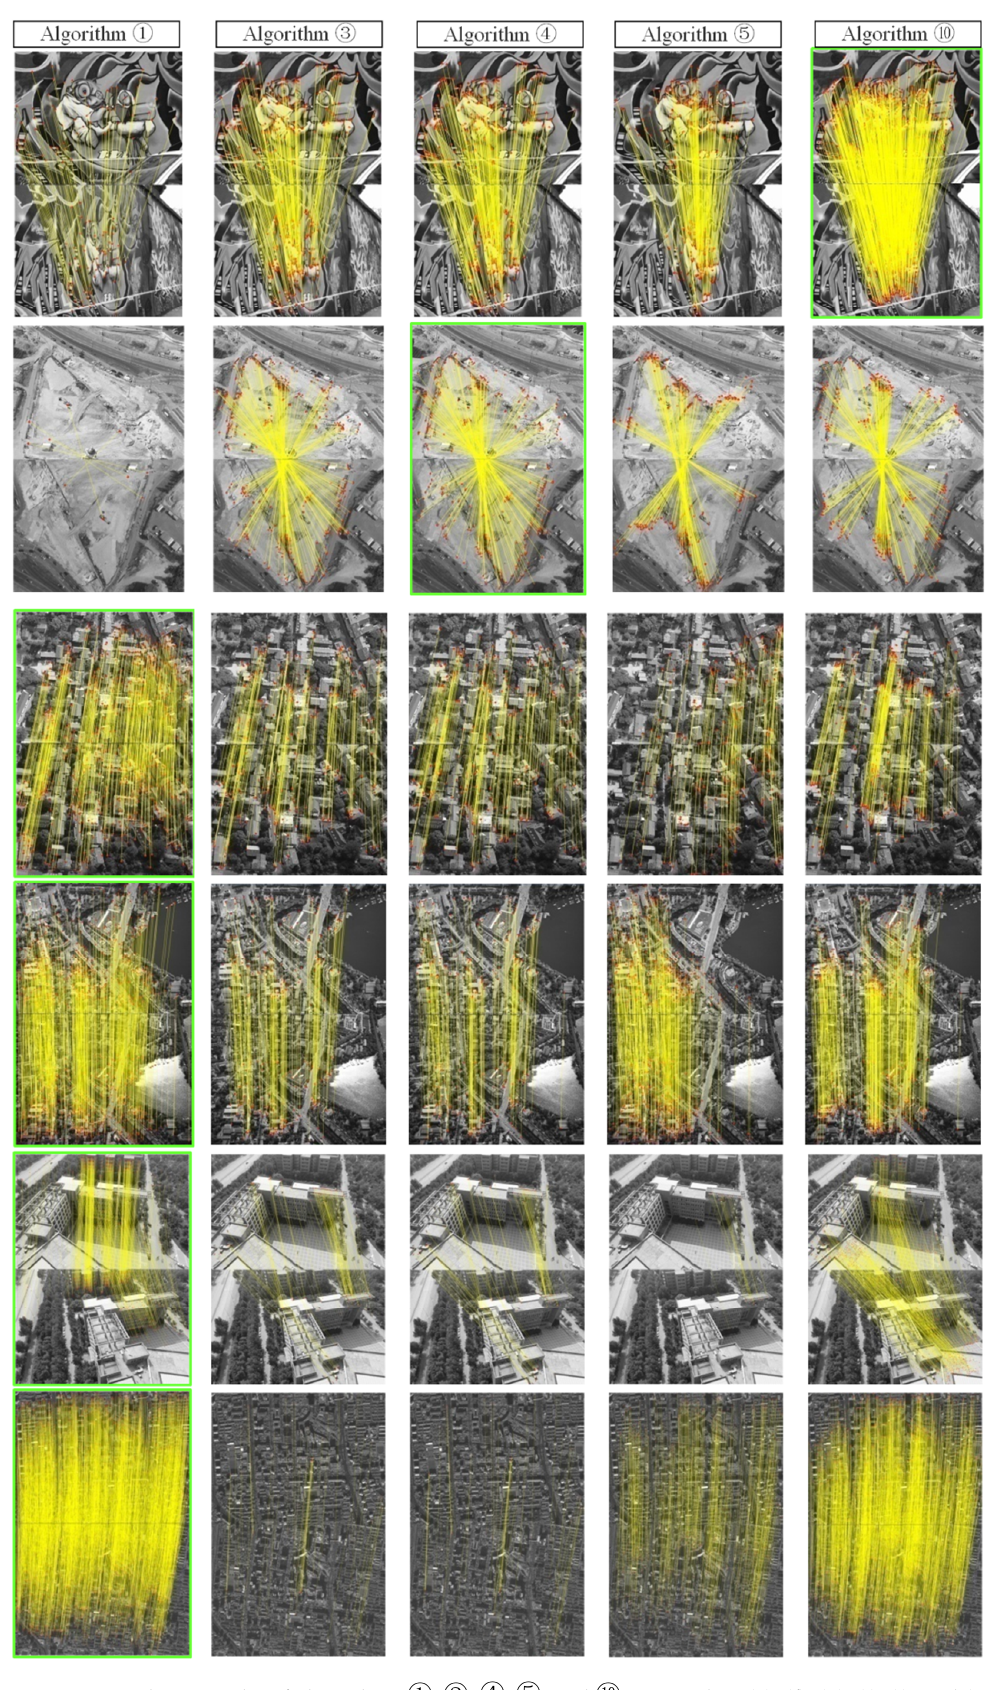
Figure 11. Matching results of algorithms ① , ③ , ④ , ⑤ , and ⑩ on test data (a), (f), (g), (i), (j), and (m).